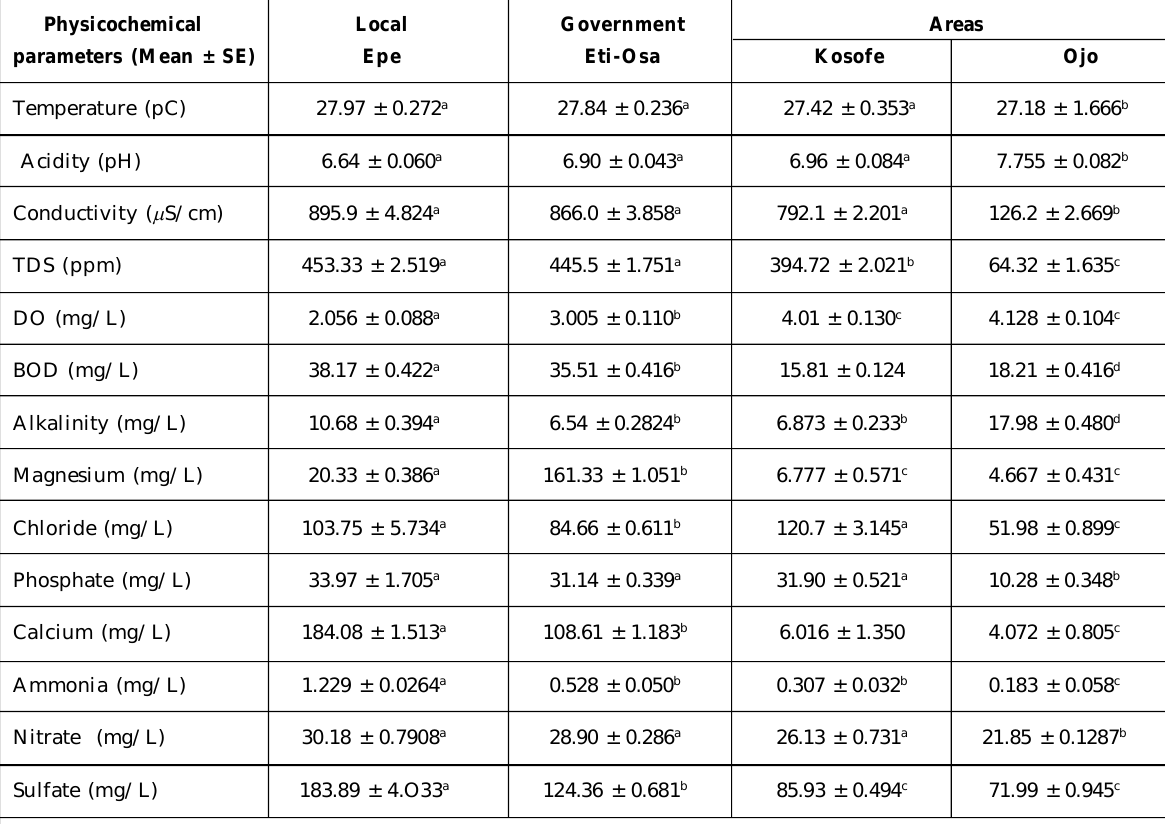
Table 2: Physicochemical parameters of Culex quinquefasciatus larval habitats Physicochemical Local Government